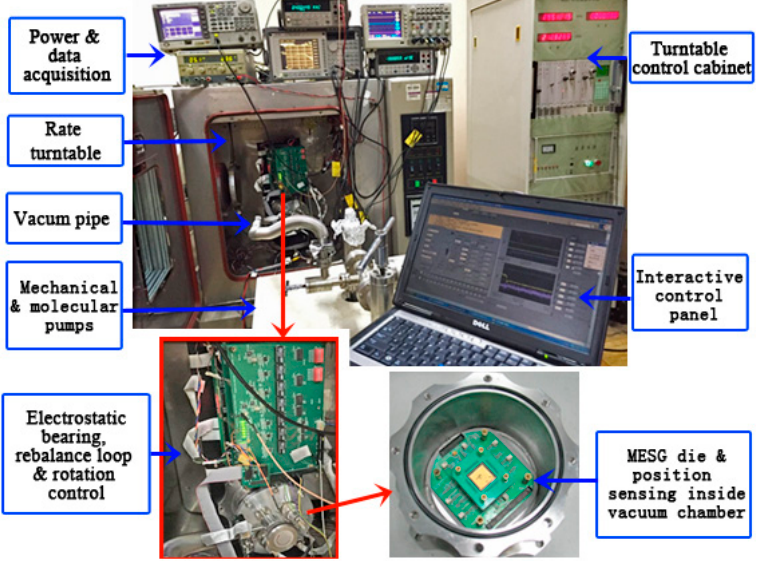
Figure 3. Test setup to study the spin rate effects on the MESG performance.